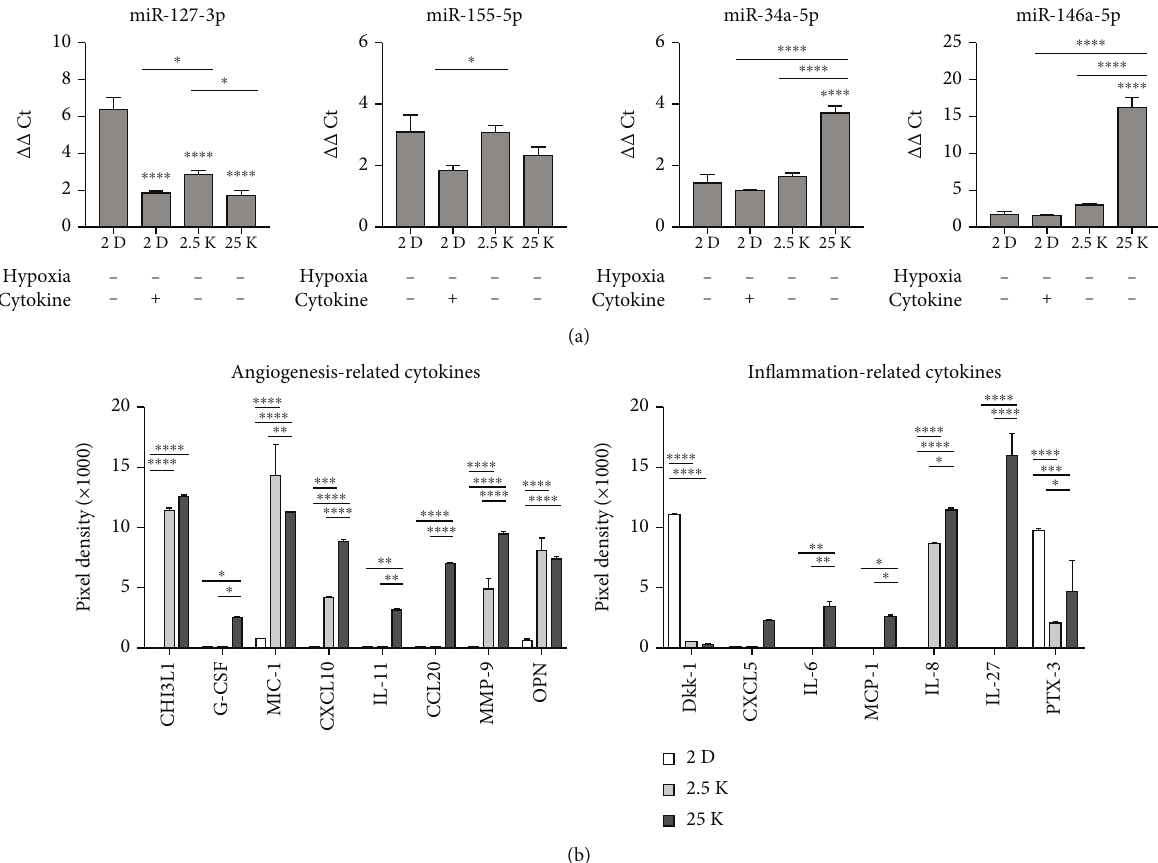
Figure 3: The cargo of hUCB-MSC-derived EVs from each condition. (a) The levels of miR-127-3p, miR-155-5p, miR-34a-5p, and miR- 146a-5p were measured by qRT-PCR in EVs derived from unstimulated 2D, cytokine (IFN- γ and TNF- α , each 40ng/mL)-stimulated 2D, and 3D hUCB-MSCs. The error bars represent the standard deviation of measurements in three separate sample runs ( n = 10 ). Signi fi cance of di ff erence was determined using one-way ANOVA with Tukey ’ s posttest. (b) Proteomic analysis of selected human cytokines from 2D and 3D hUCB-MSC-derived EVs. The error bars represent the standard deviation of measurements in two separate sample runs ( n = 4 ). Signi fi cance of di ff erence was determined using two-way ANOVA with Tukey ’ s posttest. Columns, mean; bars, SD. ∗ p < 0 : 05 , ∗∗ p < 0 : 005 , ∗∗∗ p < 0 : 0005 , and ∗∗∗∗ p < 0 : 0001